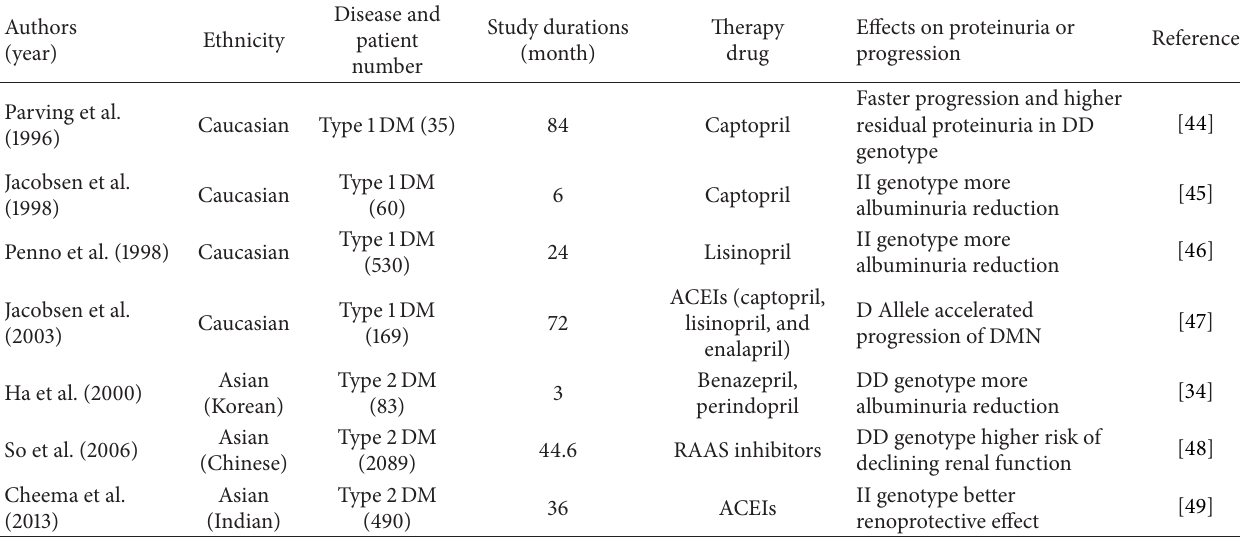
Table 1: Studies examining the association of the ACE I/D polymorphism and response to antiproteinuric (renoprotective) effect of ACE inhibitor